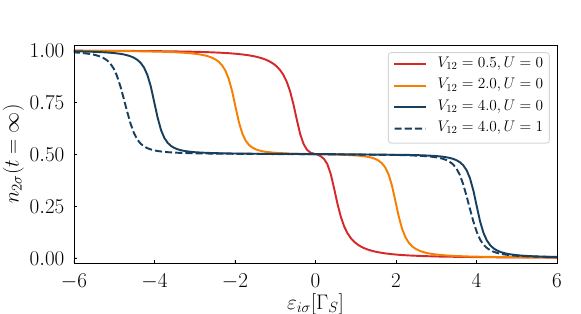
Figure 4. Charge occupancy. The stationary limit ( t ε 1 σ determined for several interdot couplings V 12 . The dashed line is calculated within the mean- level ε 2 σ = 1 . Other parameters: V field approximation for U =